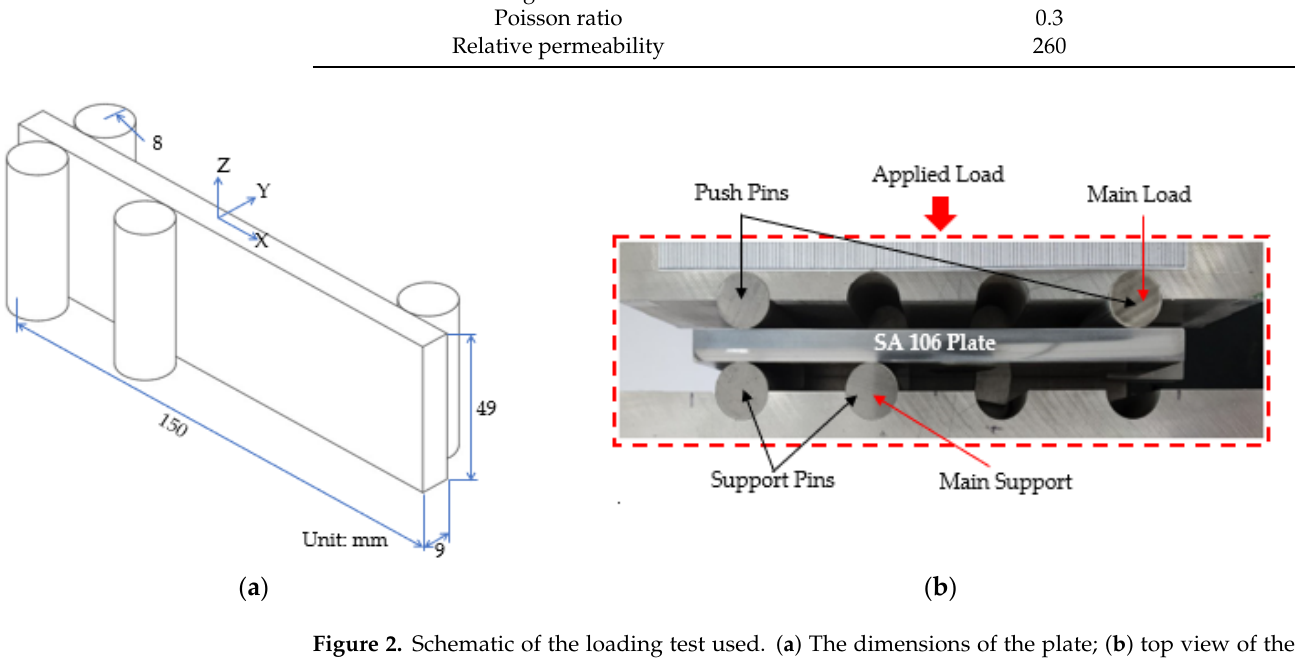
Figure 2. Schematic of the loading test used. ( a ) The dimensions of the plate; ( b ) top view of the specimen and the